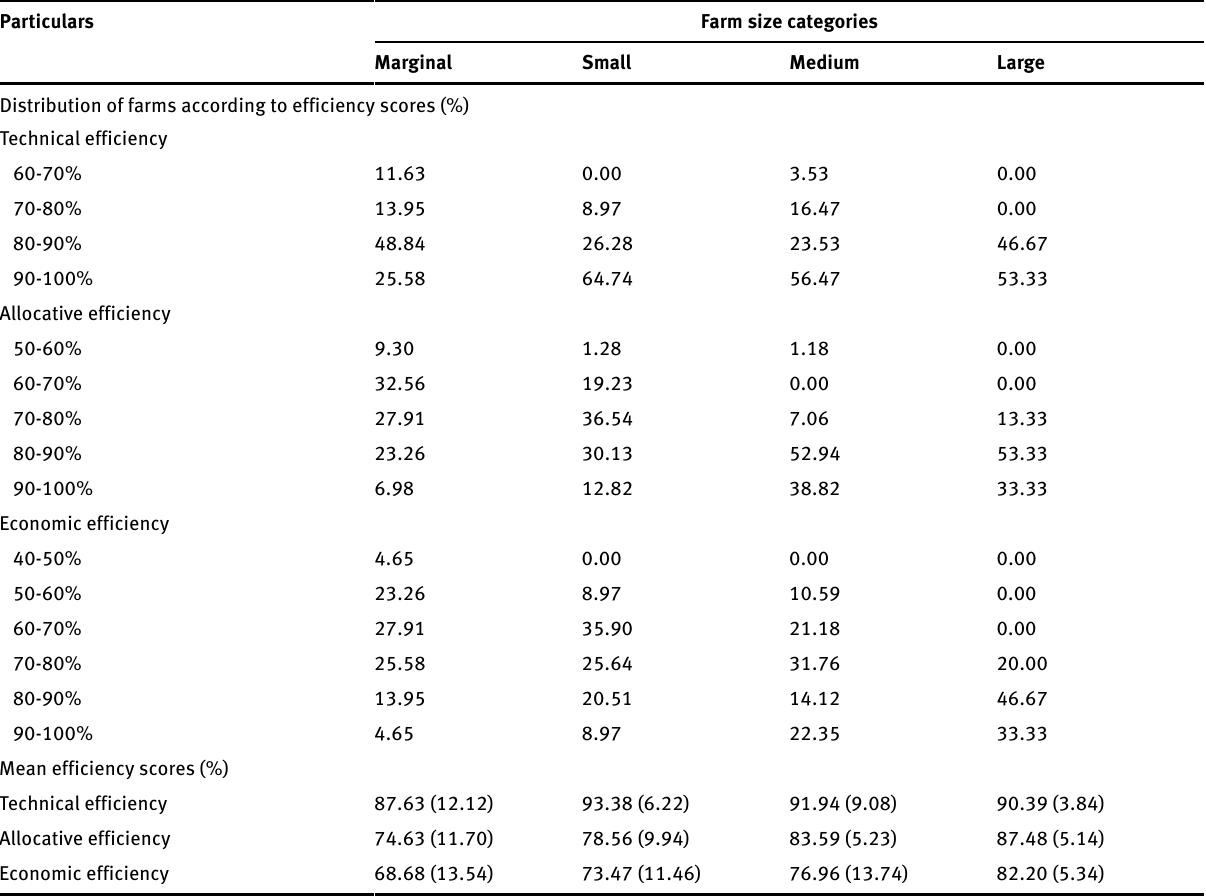
Table 2: Distribution of farms according to efficiency scores and summary statistics Particulars